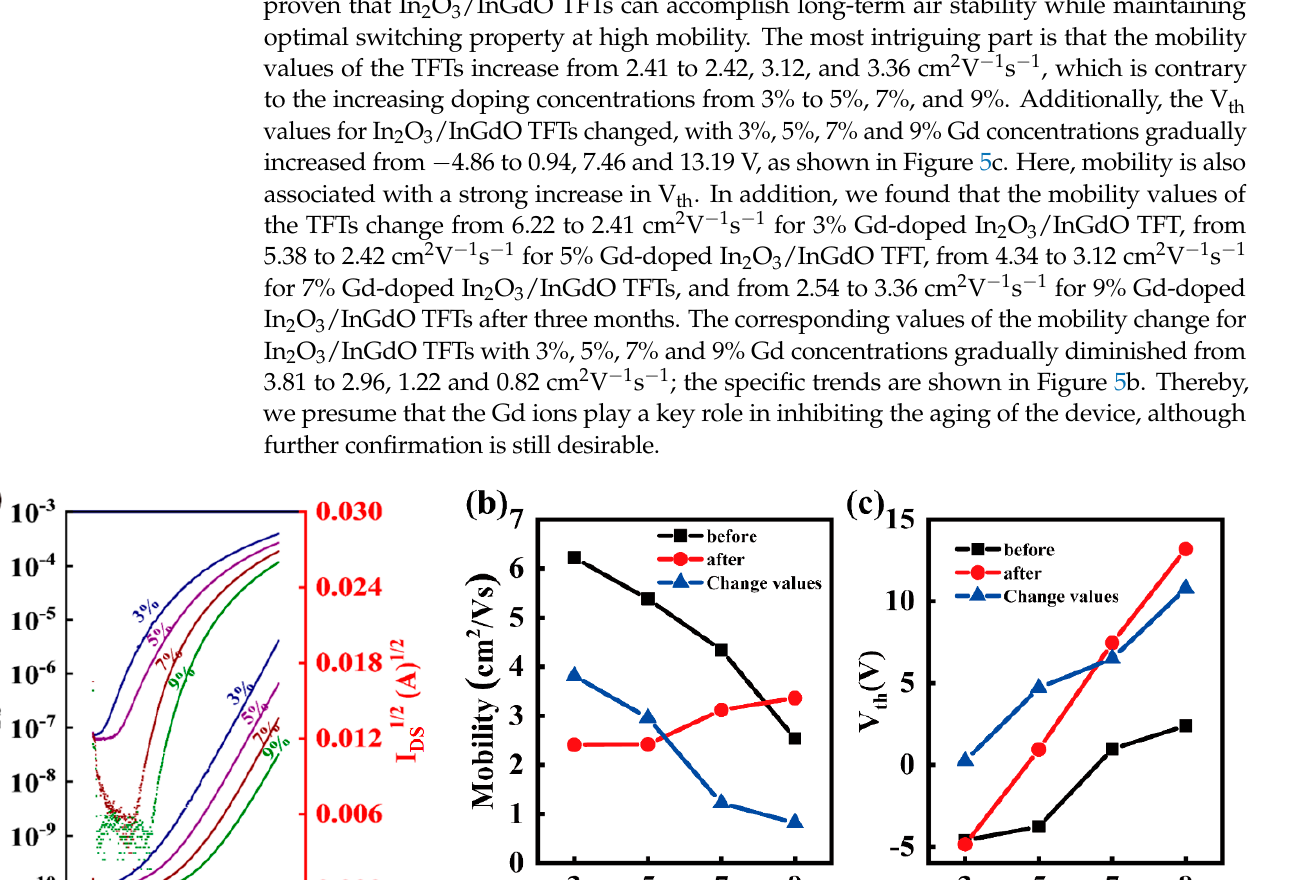
Table 2. Extracted electrical parameters in the In 2 O 3 /InGdO TFTs with various Gd doping concentrations after three months.